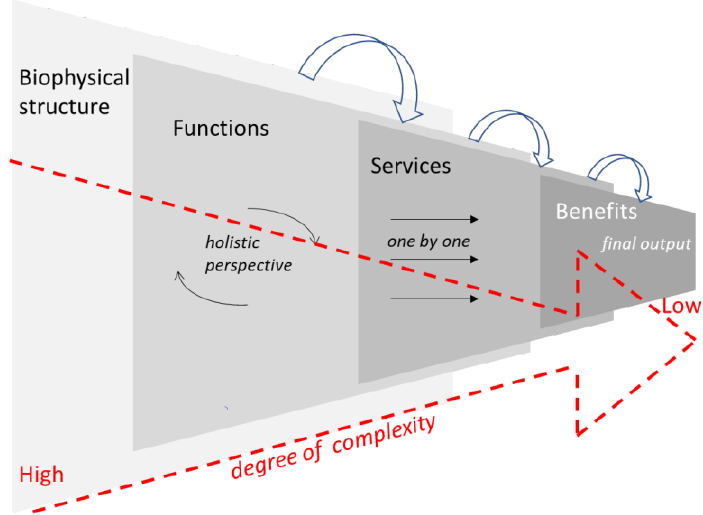
Figure 1. Telescopic cascade framework.